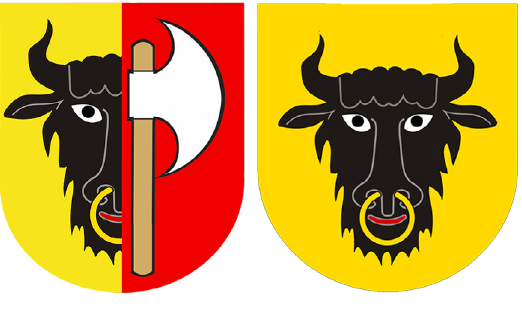
Figure 4. The former arms of Leszno and House of